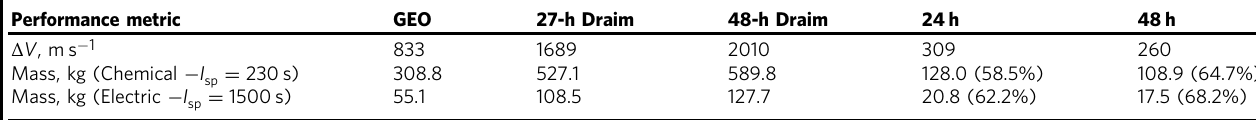
Table 1 Comparison of propellant requirements.